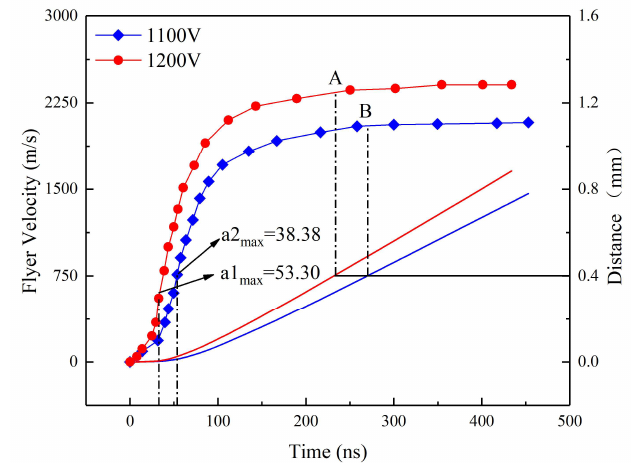
Figure 10. Velocity-time and distance-time curves of the flyer at 1100 V/0.22 μF and 1200 V/0.22 μF.